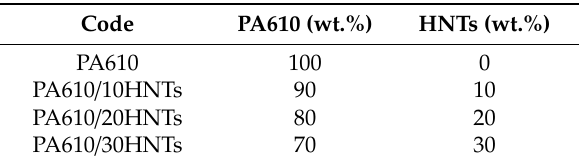
Table 1. Summary of compositions according to the weight content (wt.%) of polyamide 610 (PA610) and halloysite nanotubes